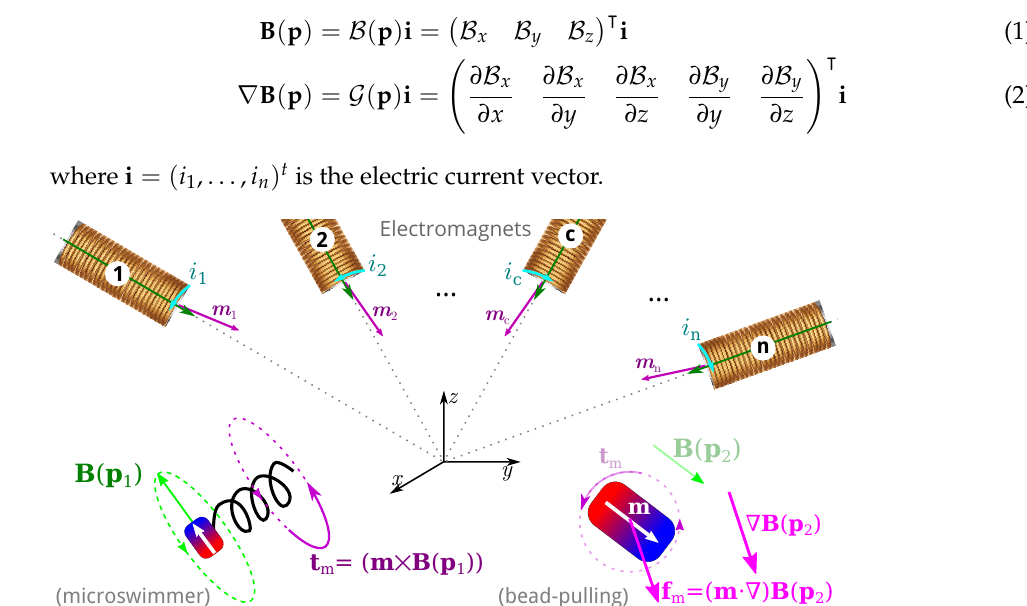
Figure 2. Illustration of the use of the magnetic manipulation of untethered